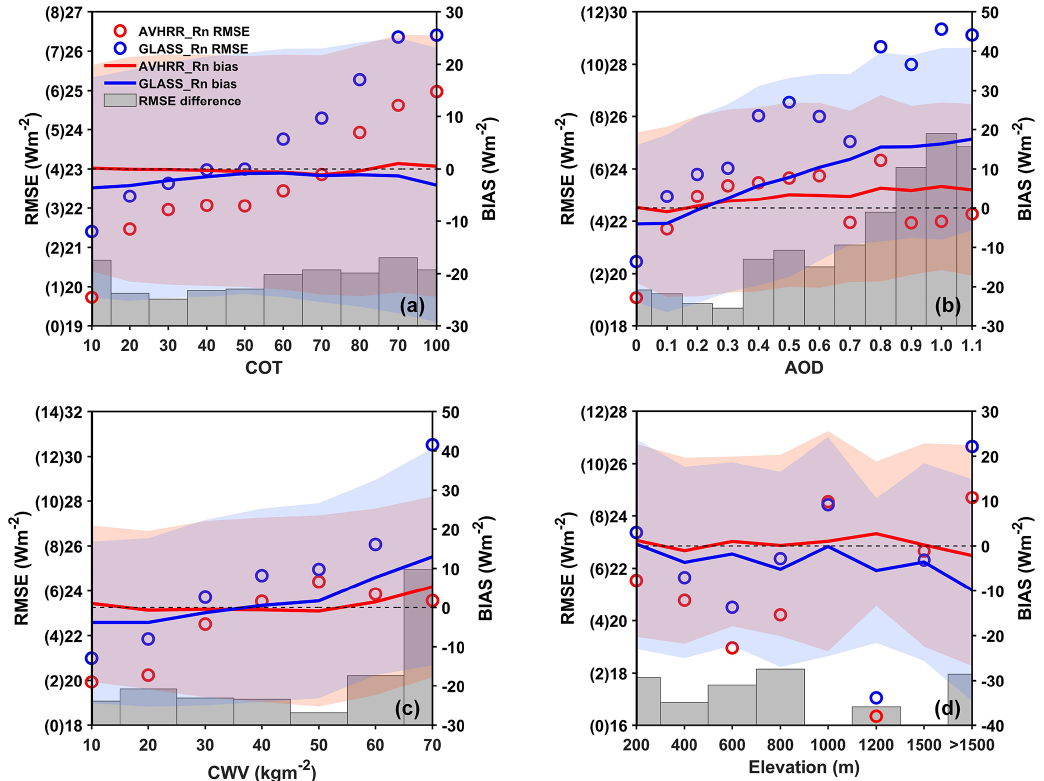
Figure 9. Accuracy changes in AVHRR and GLASS R n retrievals under different conditions for (a) cloud optical thickness (COT), (b) aerosol optical depth (AOD), (c) column water vapor (CWV), and (d) elevation. The values in parentheses on the left axis correspond to the RMSE differences denoted by bar charts. The shaded area shows the variance ranges of the biases.